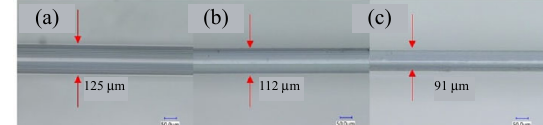
Fig. 6 Transmission spectra of PCF interferometer with different etching time in air.